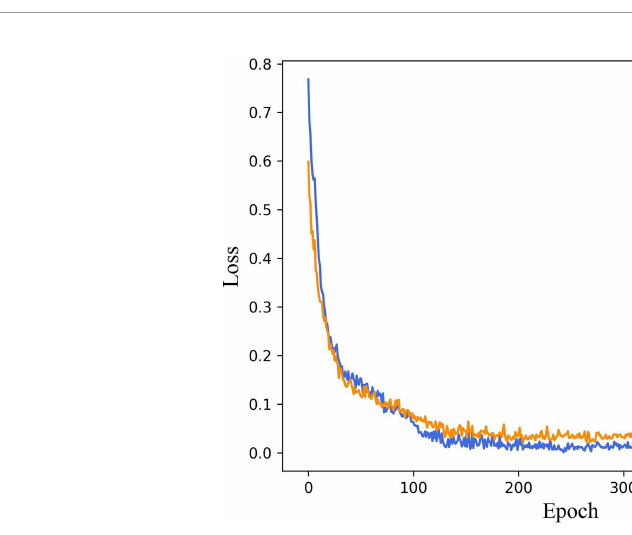
FIGURE 7 | The loss curves of DBNN.